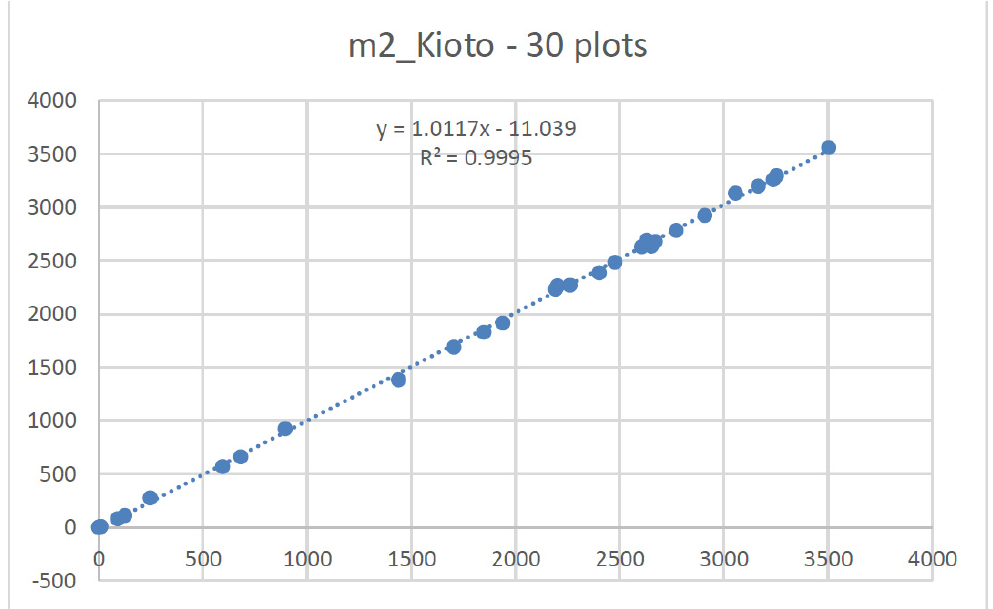
Figure A5. The reference area compared to the estimated forest area using Method 2 for test plots (30 × 30 m 2 ) as defined by the UNFCCC.